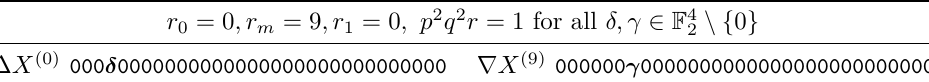
Figure 6: Sandwich distinguisher for 9 rounds of WARP . Table 2: 9-round deterministic sandwich distinguisher for WARP